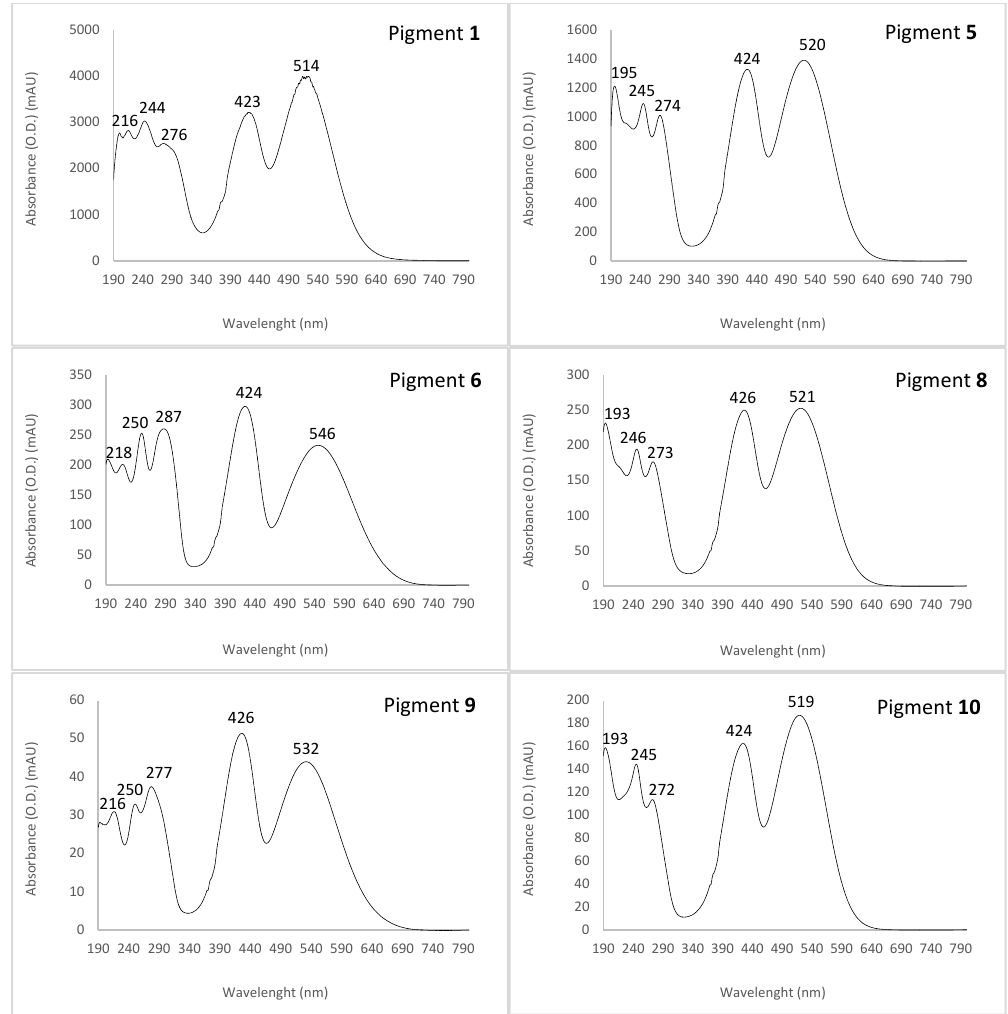
Figure 4. UV-visible absorption spectra of the major identified or assumed compounds 1 , 5 , 6 , 8 , 9 and 10 detected in intracellular extracts of the marine isolate Talaromyces sp. 30570 cultivated in PDB with reference to the chromatogram shown in Figure 3. Assignment of the nitrogen-containing azaphilone red pigments were done by UV-visible spectra and HRMS according to their mass to charge ratio. Pigments: 6-[(Z)-2-Carboxyvinyl]-N-GABA-PP-V 6 ; N -threonine-monascorubramin 8 ; N -glutaryl-rubropunctamin 9 ; and monascorubramin 10 . Pigment 1 , not tentatively